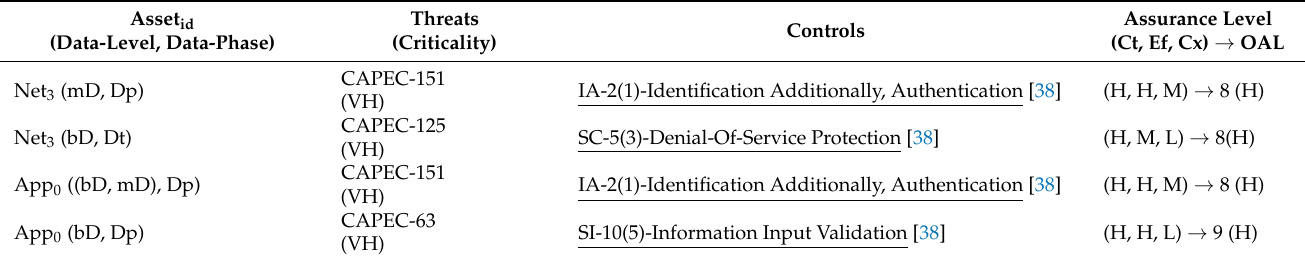
Table 8. A table representing threat controls to protect (Bs 0 )